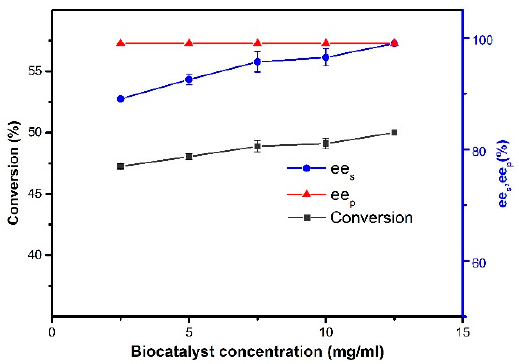
Figure 11. Effect of biocatalyst concentration on the resolution of 1-phenylethanol. Reactions performed with 2 mL of n-hexane containing 0.2 mmol of 1-phenylethanol and 0.4 mmol of vinyl acetate at 50 °C for 48 h.